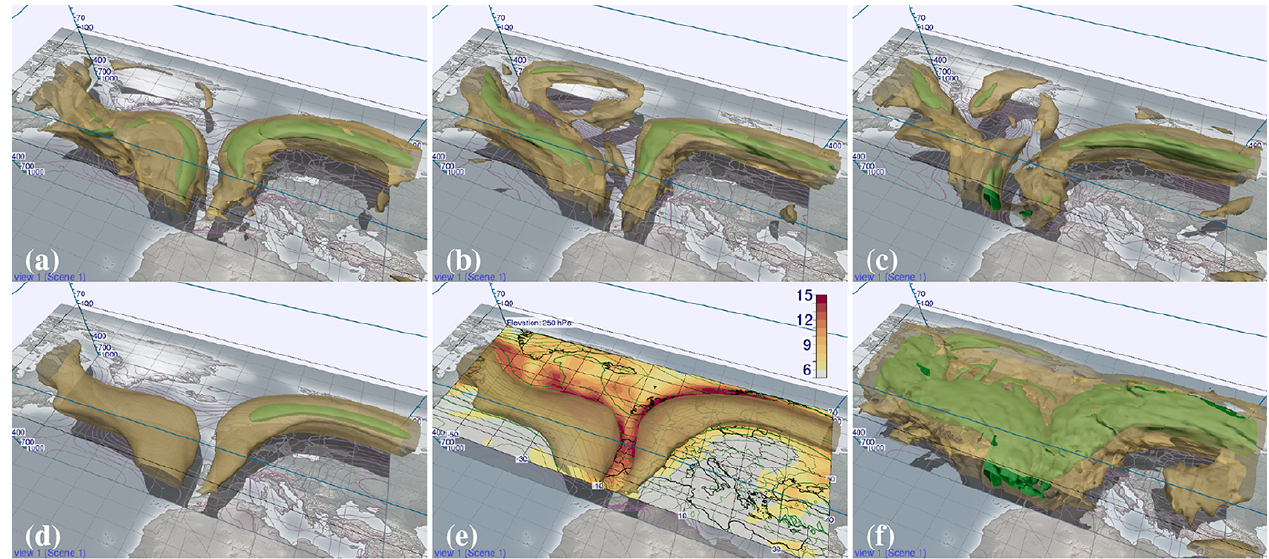
Figure 6. Navigation through the ensemble. Visualized are the 50ms − 1 (green opaque) and 30ms − 1 (yellow transparent) isosurfaces of horizontal wind speed (forecast from 00:00UTC, 15 October valid at 18:00UTC, 19 October 2012). (a) Control run, members (b) 27 and (c) 33, (d) ensemble mean, (e) ensemble mean augmented by a horizontal section of SD (ms − 1 ), (f) ensemble maximum (animated version of this figure in the Supplement at